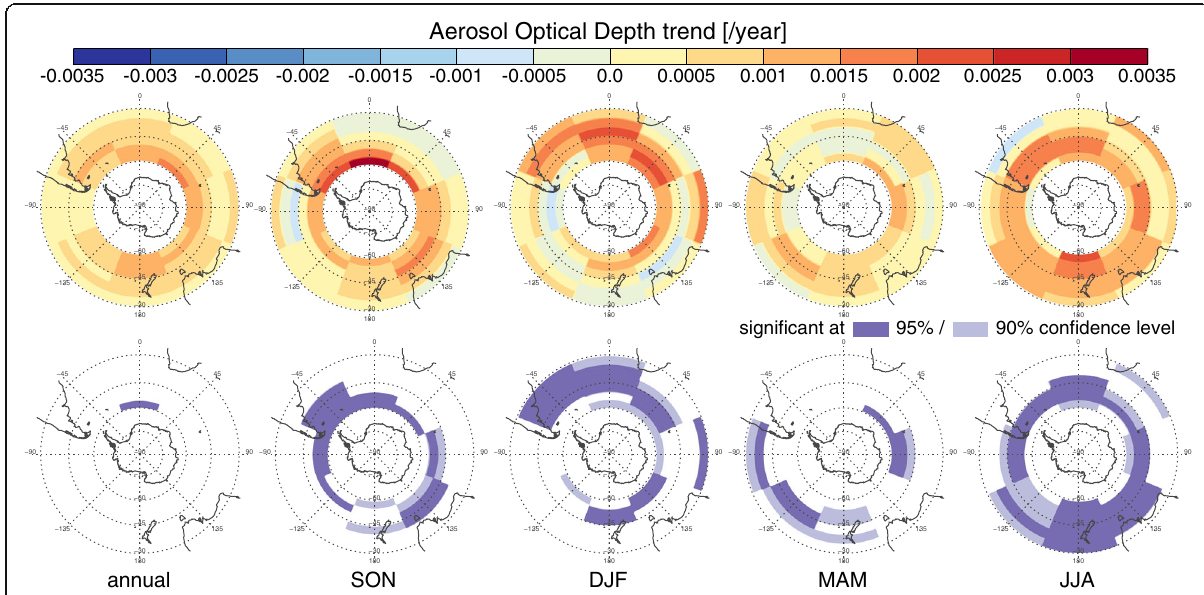
Fig. 7 Spatial distribution of linear trends (top, /year) and p values (bottom) for deseasonalized AOD results at 550 nm in the Southern Hemisphere (30 – 60° S) from 2005 to 2016. The first column shows the annual trend; other columns show seasonal trends. The regions showing statistically significant trends are colored deep purple ( p < 0.05) or light purple ( p <